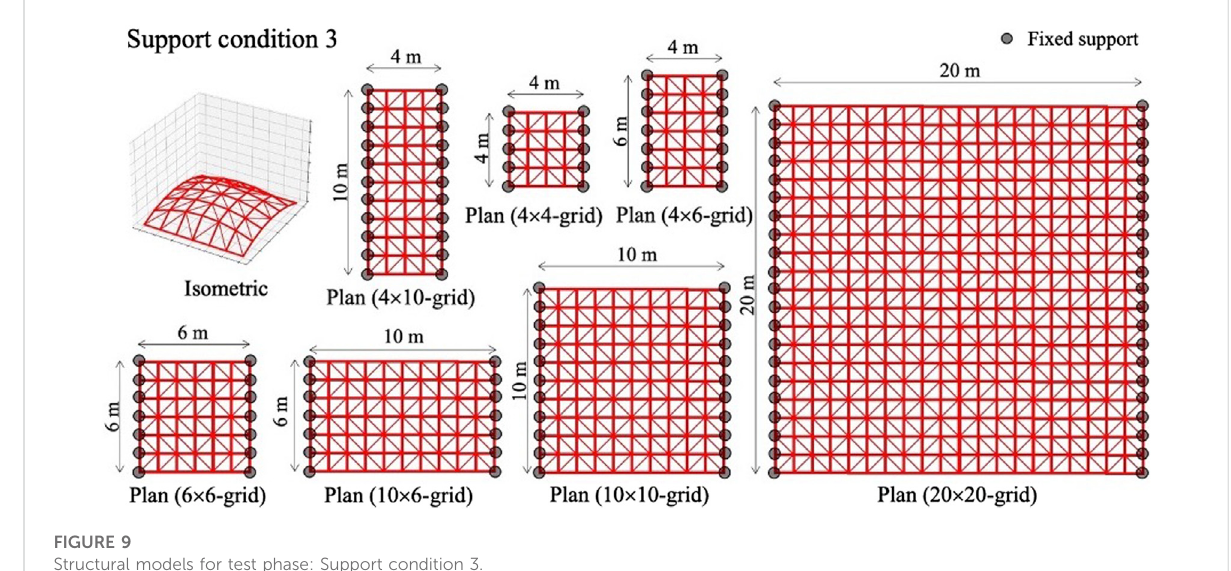
FIGURE 9 Structural models for test phase: Support condition 3.